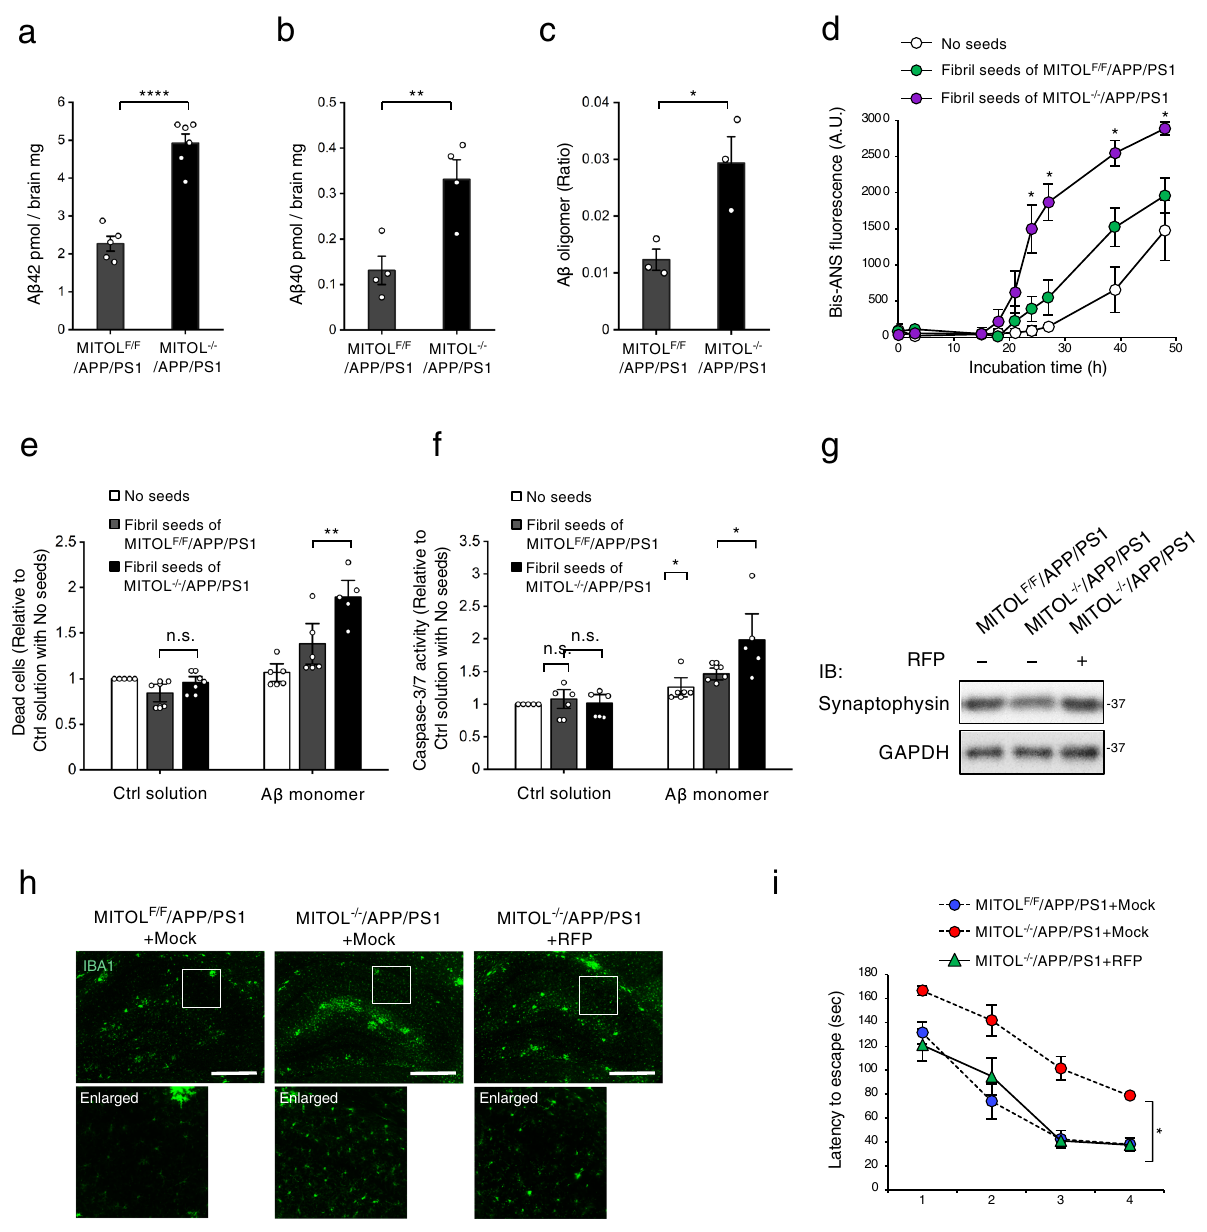
Fig. 4 MITOL deletion increases toxic A β oligomer partly via the enhanced seeding activity of A β fi brils, leading to a higher neuronal injury. a – c MITOL deletion increased soluble A β oligomers. The TBS-soluble fraction was isolated from the cerebral cortex of indicated mice at 15 months of age to performed ELISA measurement of A β 42 ( a ), A β 40 ( b ), and A β oligomers ( c ). Error bars indicate ±SE ( a – c : n = 3 – 6). **** p < 0.0001, ** p < 0.01, * p < 0.05 (Student ’ s t test). d A β fi brils containing the plaques from the MITOL-deleted APP/PS1 brain exhibited a dramatic seeding effect on the oligomerization of free A β monomers. A β fi brils in indicated 15-months old mice were isolated and puri fi ed as described in “ Method ” . The fi brils were co-incubated with seed- free A β 40 monomers as aggregation seeds for indicated periods as described in “ Method ” and the oligomerization was monitored by Bis-ANS. As a control, TBS solution was used (no seeds). Error bars indicate ±SE ( n = 5). ** p < 0.01, * p < 0.05, n.s.: not signi fi cant (Student ’ s t test). e , f A β fi brils from MITOL-delated APP/PS1 boosted the neurotoxicity of free A β monomers. Puri fi ed amyloids of indicated mice were co-incubated with or without seed-free A β 40 monomers for 24 h as described in “ Method ” . These co-incubated solutions were added into the growth medium of SH-SY5Y cells at the 25 µ M fi nal concentration of A β 40. After 48 h, dead cells were detected by LDH release assay ( e ) and Caspase-Glo 3/7 assay, respectively ( f ). Error bars indicate ±SE ( n = 5). * p < 0.05, n.s.: not signi fi cant (Student ’ s t test). g – i RFP injection ameliorated the severe neurological and cognitive symptoms in MITOL-deleted APP/PS1 mice. RFP was treated as described in “ Method ” . As a control, the solvent for RFP was also treated (Mock) ( g – i ). The hippocampus of indicated mice at 15 months of age was analyzed by immunoblotting ( g ) and immunostaining ( h ), respectively, using indicated antibodies. Barnes maze test was performed to evaluate learning memory of indicated mice at 15 months of age ( i ). Error bars indicate ±SE ( n = 6 – 7). * p < 0.05 (Student ’ s t test).